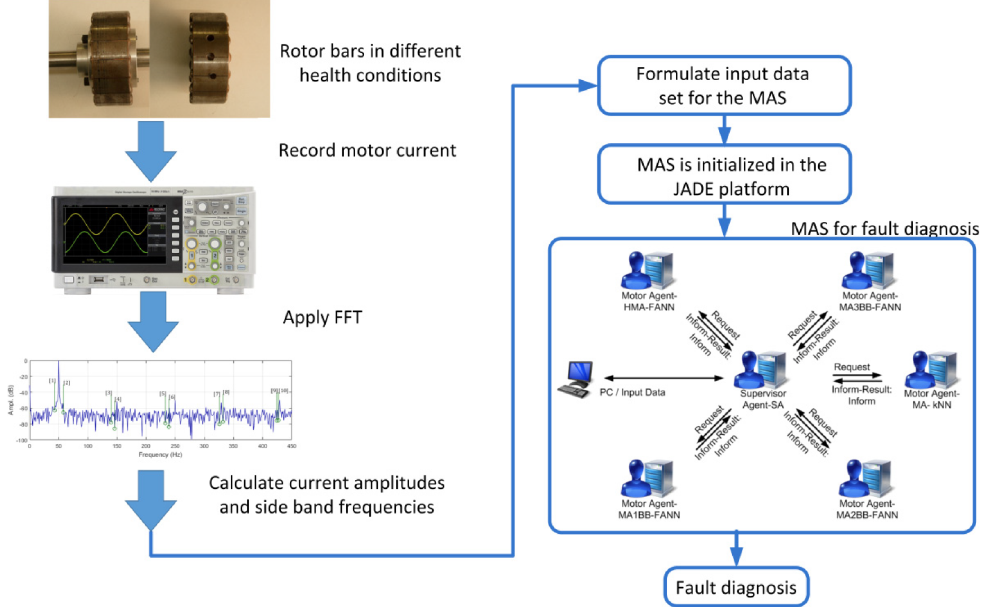
Figure 3. MAS based FD/D decision support framework (Drakaki et al.,